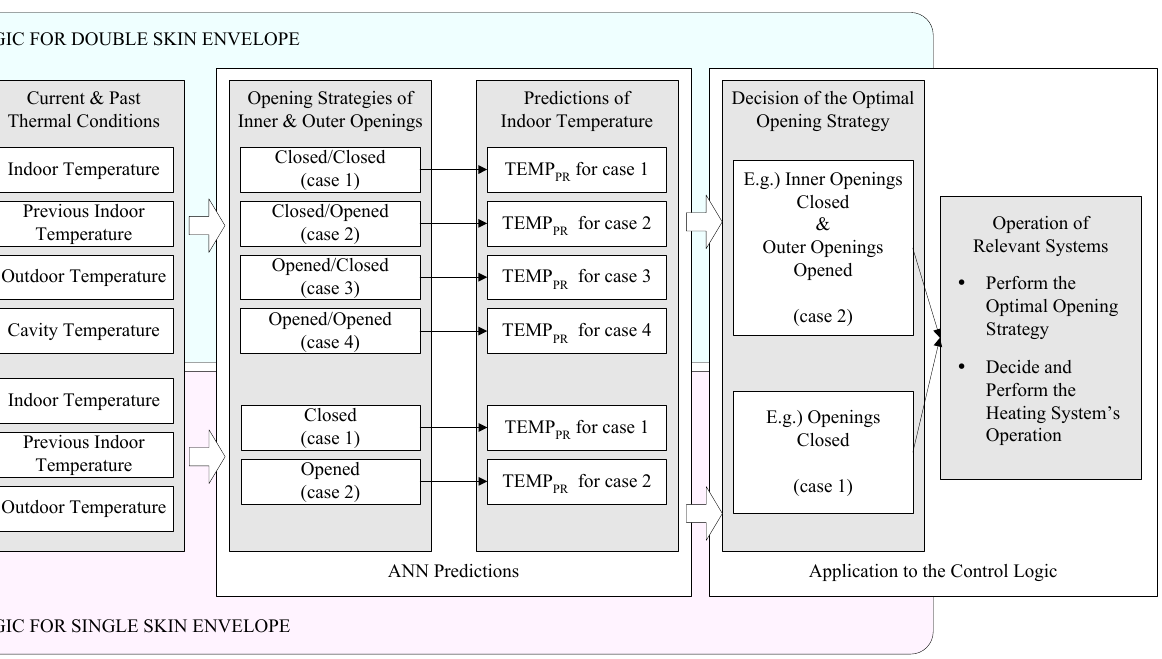
Figure 1. Incorporative process between the artificial neural network (ANN) model and control